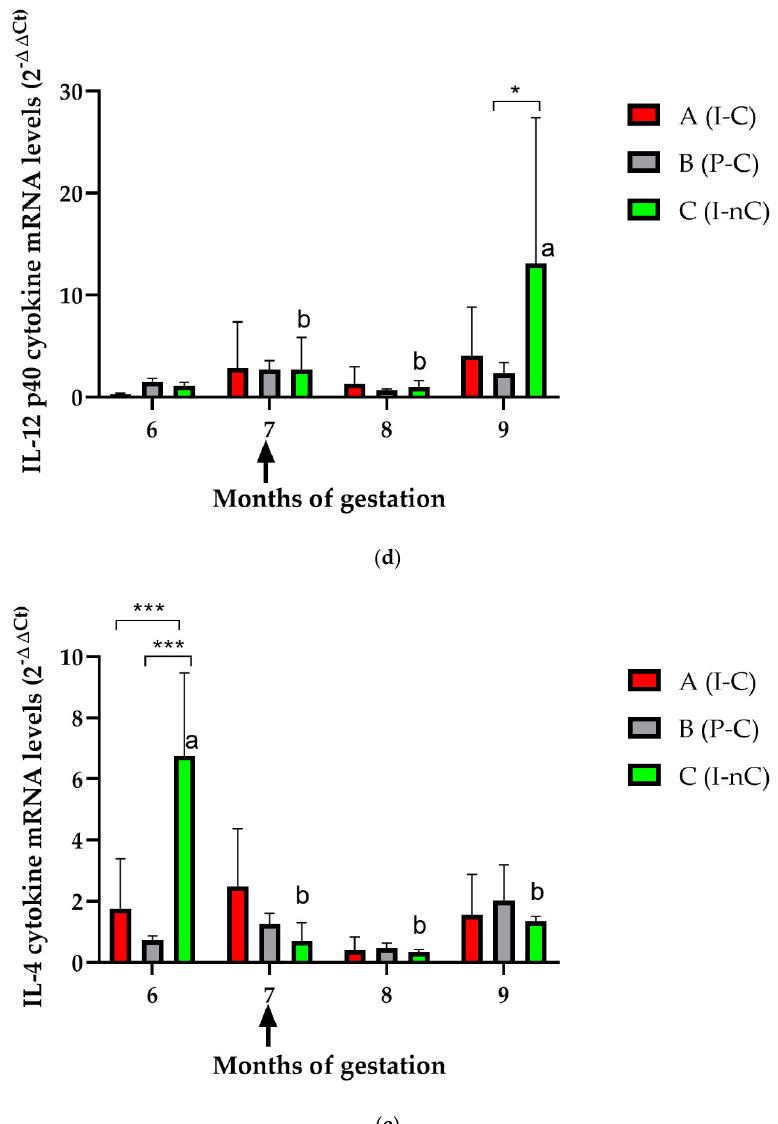
Figure 3. Interleaved-bar graphs of relative cytokine mRNA expression levels in PBMCs in heifers from Groups A (inoculated and challenged (I-C)), B (placebo and challenged (P-C)), and C (inoculated and not challenged (I-nC)). Relative quantification of cytokine mRNA expression levels was carried out using the 2 −ΔΔ Ct method. The numbers on the Y-axis represent the mean fold change in cytokine mRNA expression levels relative to Group D (placebo and no challenge (P-nC), i.e., the negative control). Error bars represent the SD. ( a ) IL-10; ( b ) INF- γ ; ( c ) TNF- α ; ( d ) IL-12 p40; and ( e ) IL-4. Upwards arrow: day of challenge (210 days of gestation). The significant differences among groups were analysed. *** p < 0.0001; ** p < 0.001; * p < 0.05. Letters indicate significant differences in each group over time.